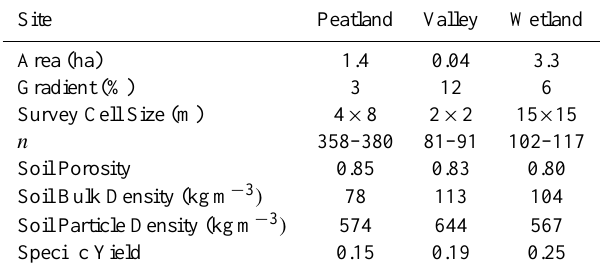
Table 1. Site area, topographic gradient based on 1m by 1m digital elevation model, size of the survey grids, total number of shallow soil moisture and frost table sample points ( n ) and shallow soil char- acteristics (top